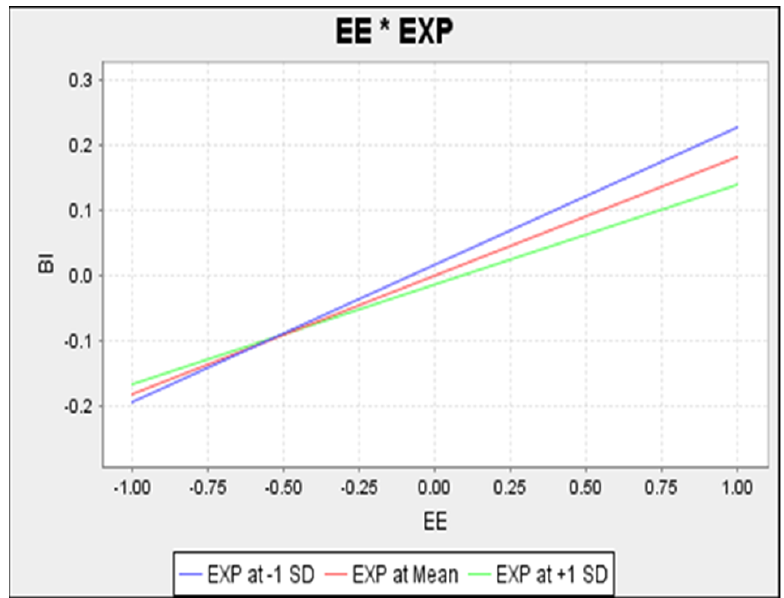
Figure 5. Simple Slope Analysis of Effort Expectancy on Behavioural Intention.